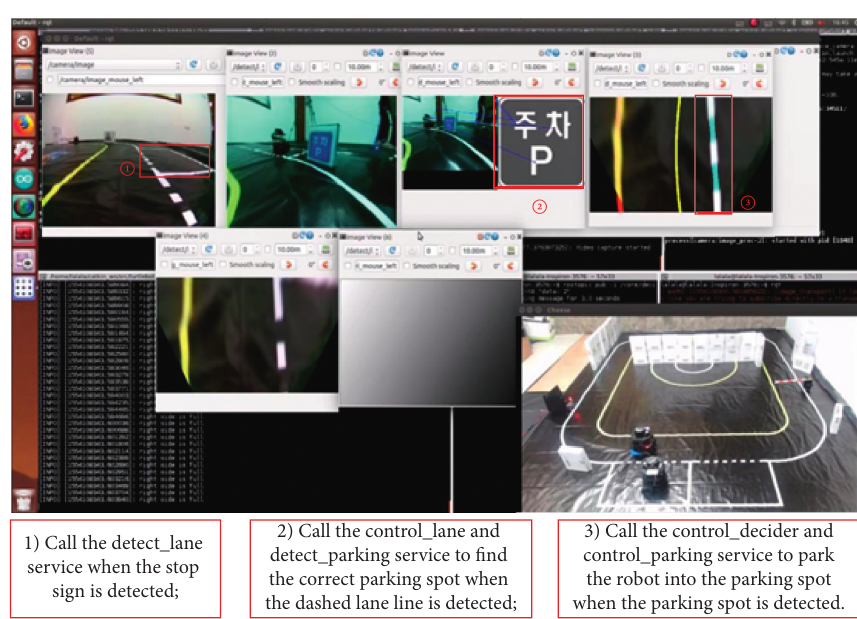
Figure 7: Delivery of the prop to a designated parking spot.